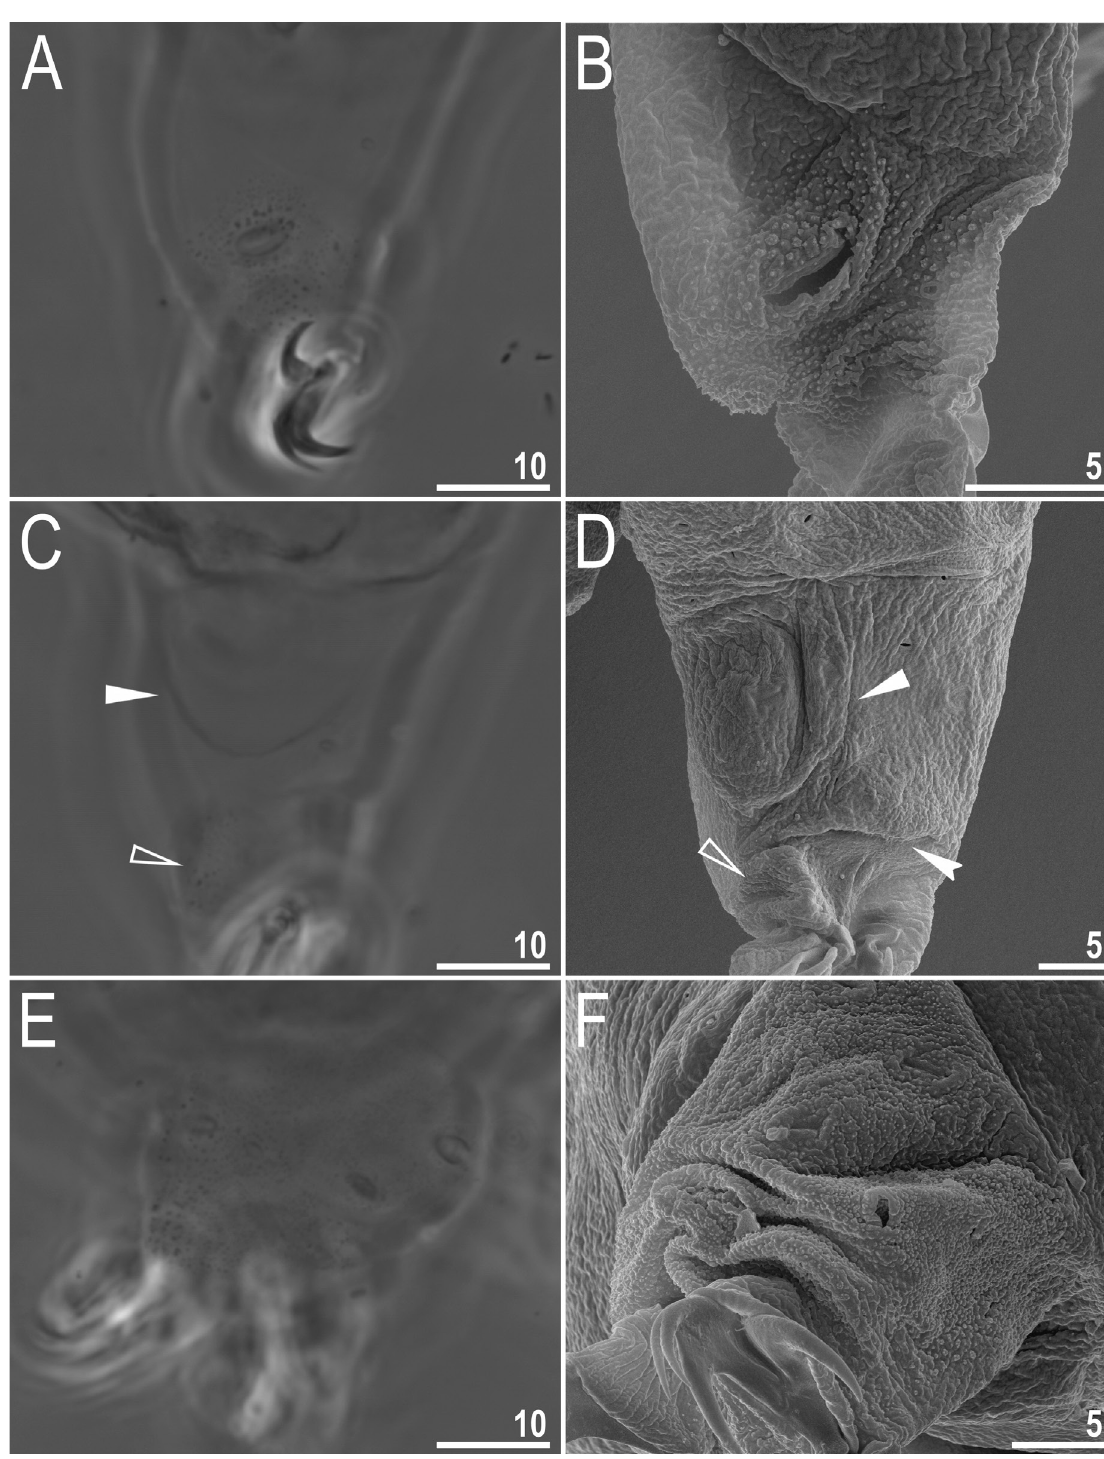
Fig. 3. Macrobiotus engbergi sp. nov. Cuticular structures on legs (paratypes). A – B . External granulation on leg III and II seen in PCM (A) and SEM (B), respectively. C – D . A cuticular bulge (pulvinus) and a faint cuticular fold, covered by granulation, on the internal surface of legs III seen in PCM (C) and SEM (D), respectively. E – F . Granulation on leg IV seen in PCM (E) and SEM (F). Filled flat arrowheads indicate the cuticular bulge, empty flat arrowheads indicate the faint cuticular fold under the claws whereas filled indented arrowhead indicate double muscle attachments under claws. Scale bars in